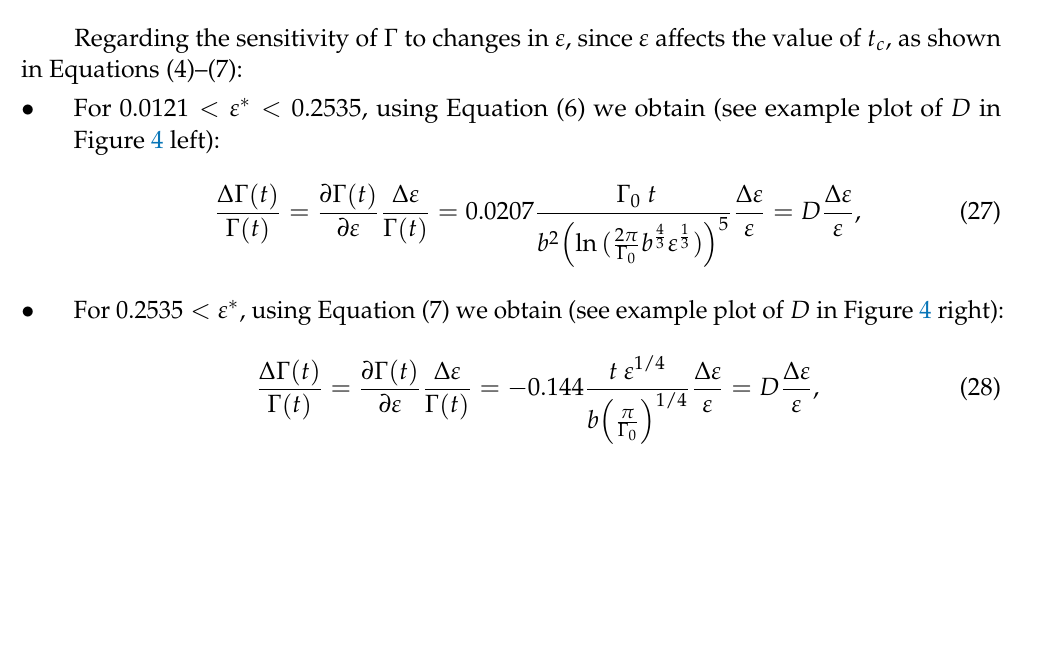
Figure 3. Parameter C = 0.55 ( t / t c ) and Γ ( t ) = Γ 0 exp ( − 0.55 ( t / t c )) vs. time of the catastrophic wake demise event 𝑡 𝑐 , for 𝑡 = 100 s and Γ 0 = 100 m 2 /s.